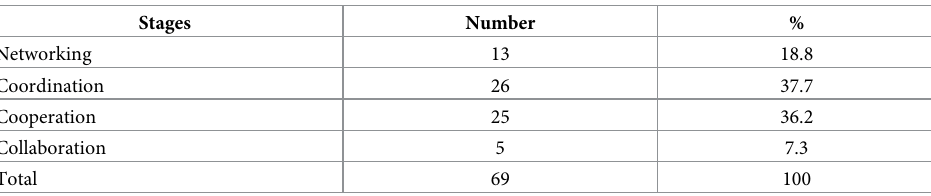
Table 6. Stages of the